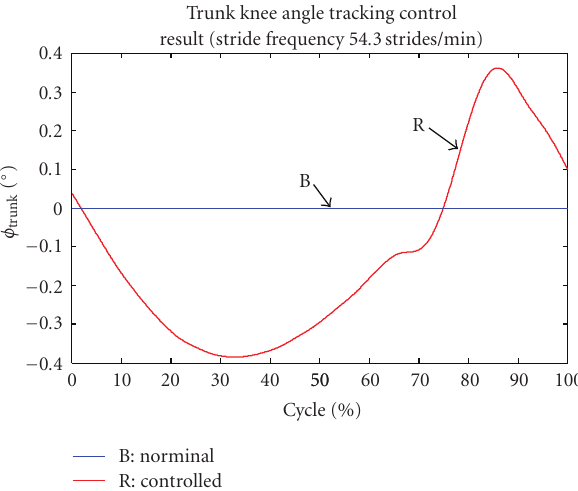
Figure 19: The controller tracking performance of the hip joint angle and regulation performance of the trunk angle via the hip